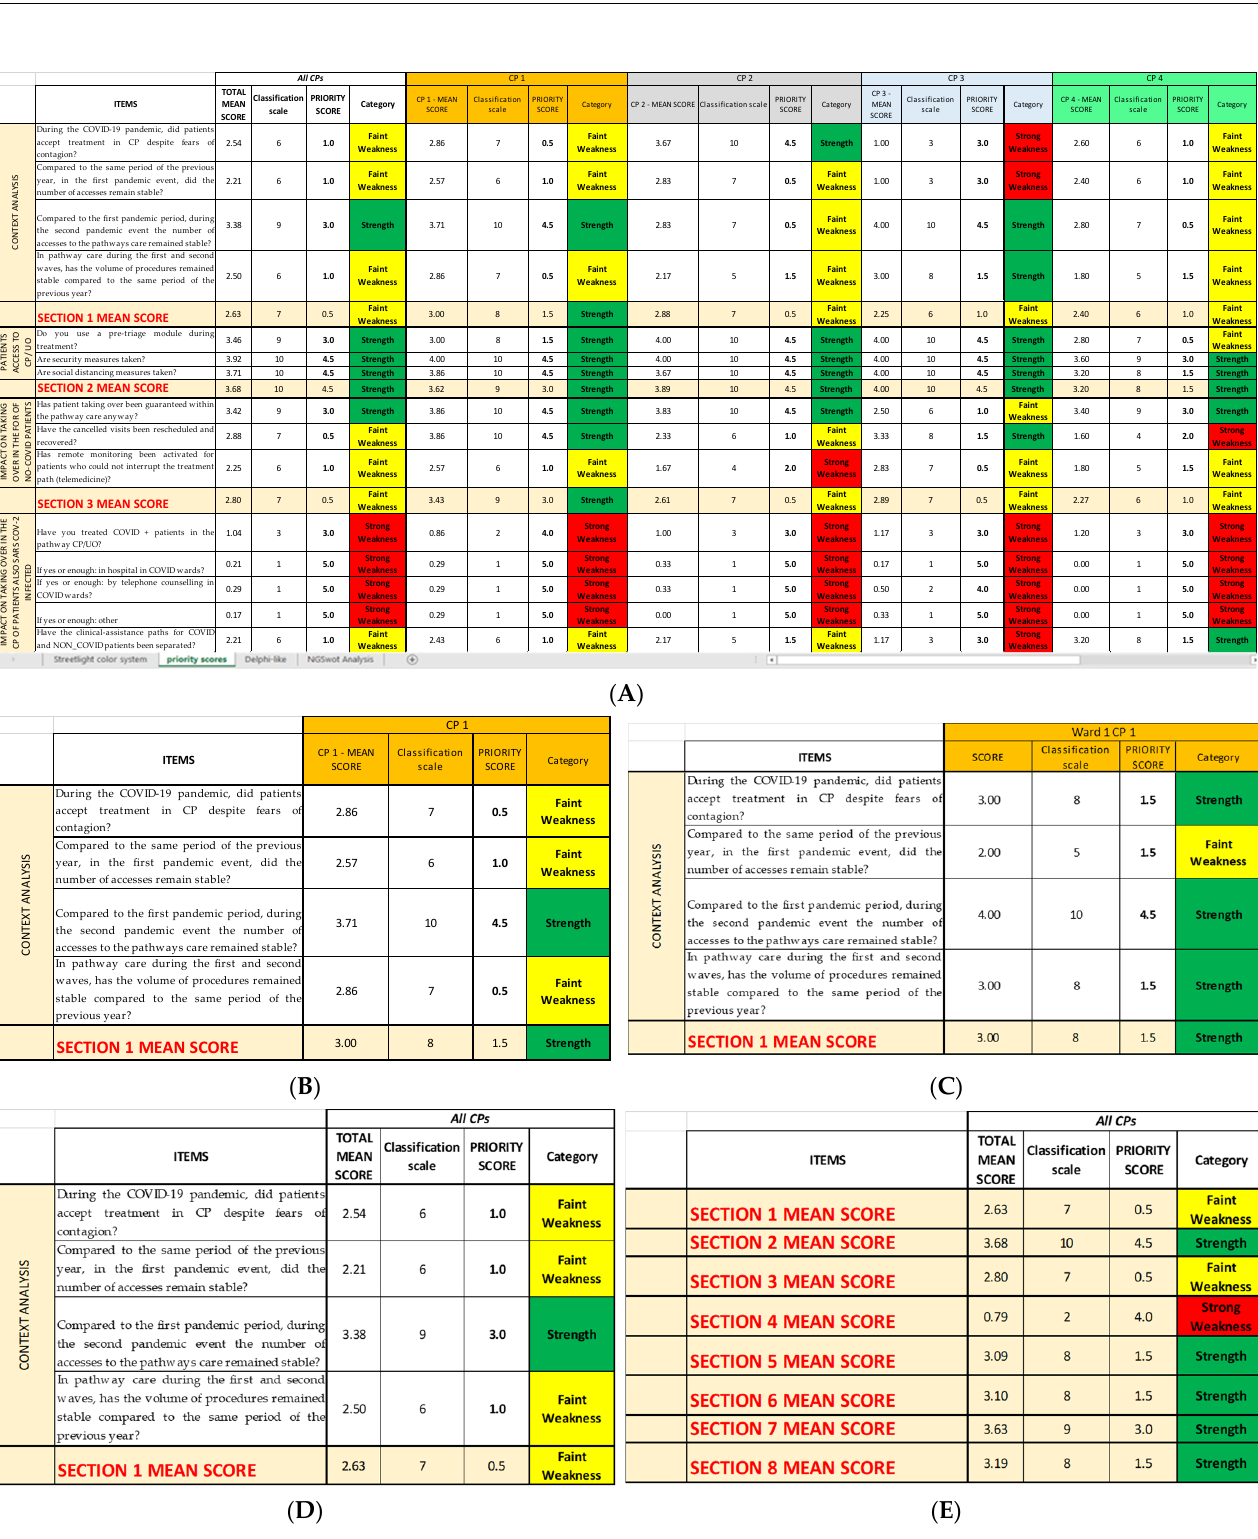
Figure 7. ( A ) Photograph of the Priority scores sheet of SPRIS; for each mean score, we report the correspondent classification scale, the priority score, and the category, following the conversion table. ( B ) Extraction of the Priority scores sheet regarding the first Questionnaire Section of the survey referring to the first CP considered. ( C ) Extraction regarding the first ward considered (vertical reading of the streetlight color system). ( D ) Extraction regarding the items of the first Questionnaire Section (horizontal reading of the Streetlight color system). ( E ) Extraction regarding all eight Questionnaire Sections (horizontal reading of the streetlight color system).